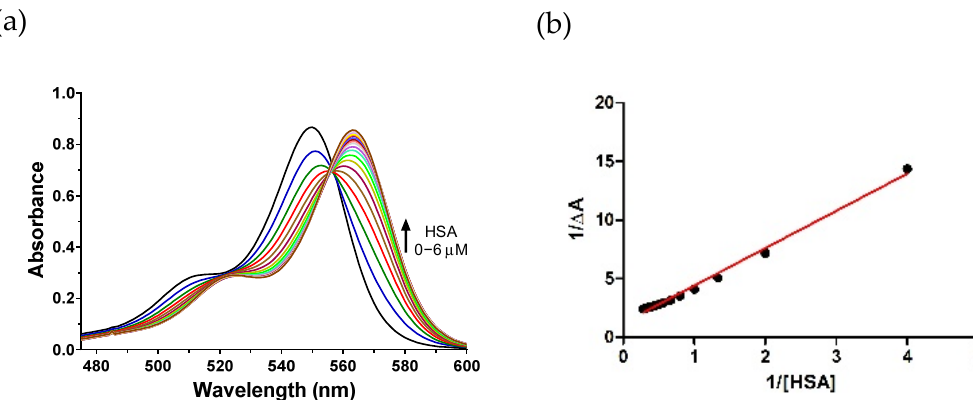
Figure 3. Result of the interaction between the RB dye and the HSA protein. ( a ) UV-vis spectrum of the RB with the addition of HSA protein (0 to 6 µ L). ( b ) Graph (Benesi-Hildebrand plot) of the inverse values of absorbance (1/ ∆ A) by the inverse of the concentration of the protein that was added (1/g[HSA]).